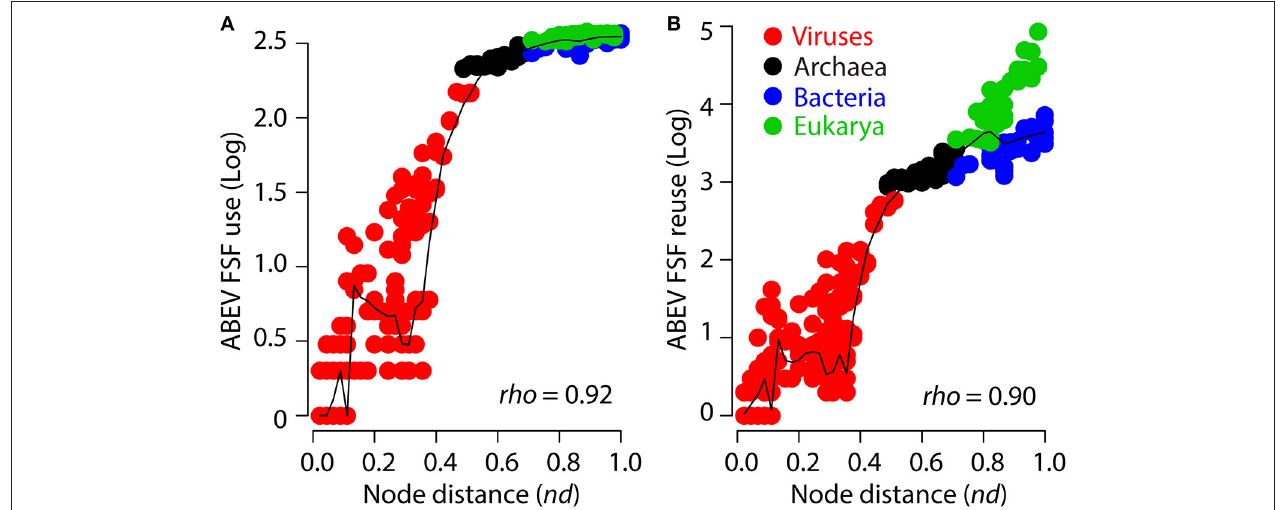
FIGURE 4 | Scatter plots describe the relationship between ABEV FSF use (A) and reuse (B) and node distance ( nd ) for the 368-taxon ToL (Nasir and Caetano-Anollés, 2015). Data points for different supergroups are colored green (Eukarya), blue (Bacteria), black (Archaea) and red (viruses). The black line describes the nature of the relationship, as determined by the Locally Weighted Regression Scatter Plot Smoothing (LOWESS) method, which obtains a smoothed curve by fitting successive regression functions ( q = 0.1, i = 100). The plot reveals high scatter, especially toward smaller nd values and clustering of bacterial and eukaryal taxa in the same nd range despite harboring big differences in FSF use and reuse